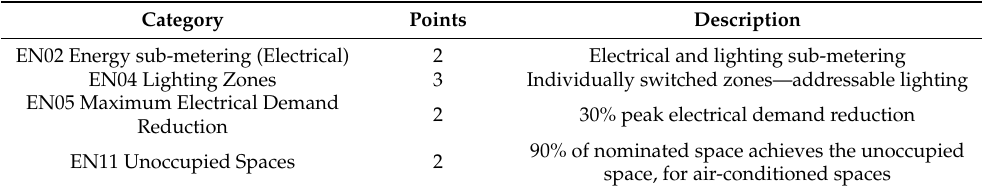
Table 4. Project scorecard EMS College—Energy category.